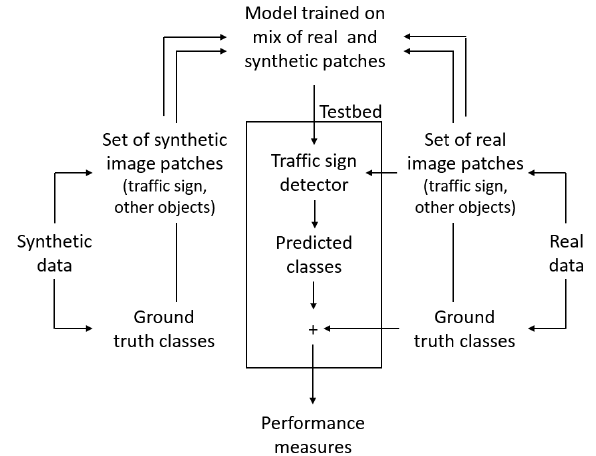
Figure 8. Pipeline to evaluate the performance of traffic sign detection on synthetic images. Performance measures are ROC AUC, OA, P and R. The testbed could be extended to be able to control different variations in the virtual world, for example regarding the incidence of sunlight.